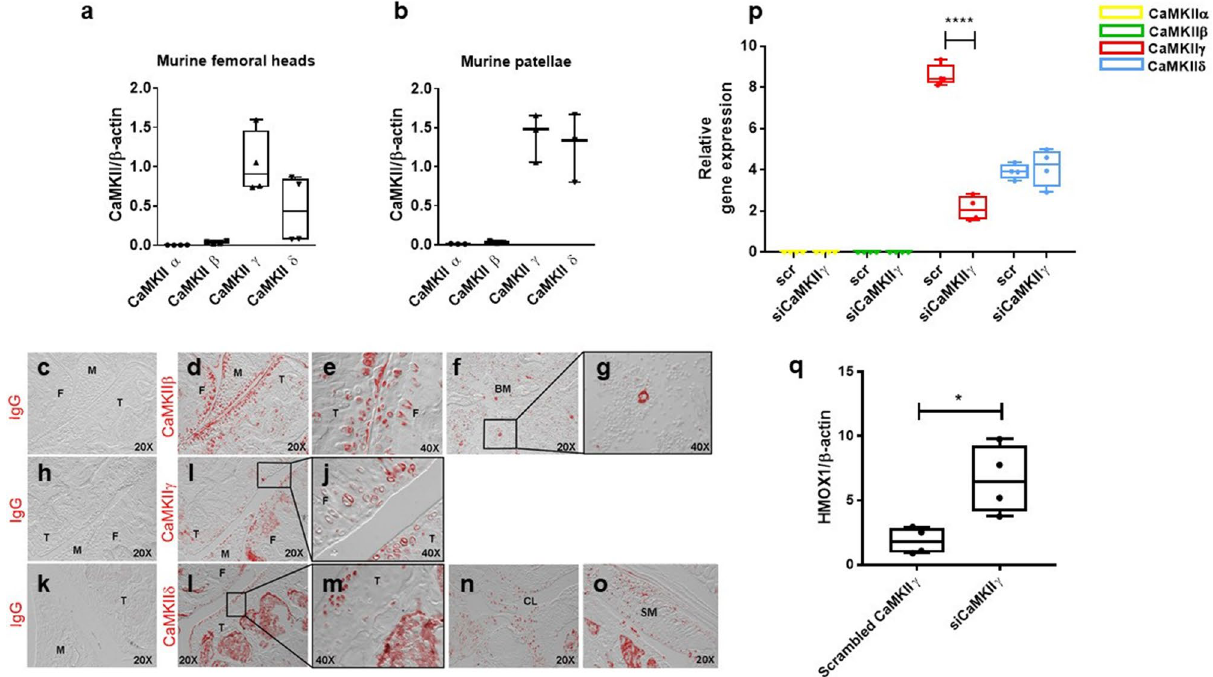
Figure 3. Expression of CaMKII isoforms in murine cartilage. ( a , b ) qPCR analysis of murine femoral heads and patellae removed from 1 month-old 129/Sv male mice (n = 4). Gene expression was normalized for the housekeeping gene beta-actin. ( c – o ) Immunofluorescence for CaMKII-β, -γ and δ in the murine joint. ( p ) mRNA expression of the CaMKII isoforms after CaMKIIγ silencing by siRNA in C3H/10T1/2 cells. n = 4. ( q ) Downregulation of CaMKII by siRNA was sufficient to upregulate HMOX1 in C3H/10T1/2 cells n = 4. Data analysed by t-test. F = femur; T = tibia; M = meniscus; BM = bone marrow; CL = cruciate ligament; SM = synovial